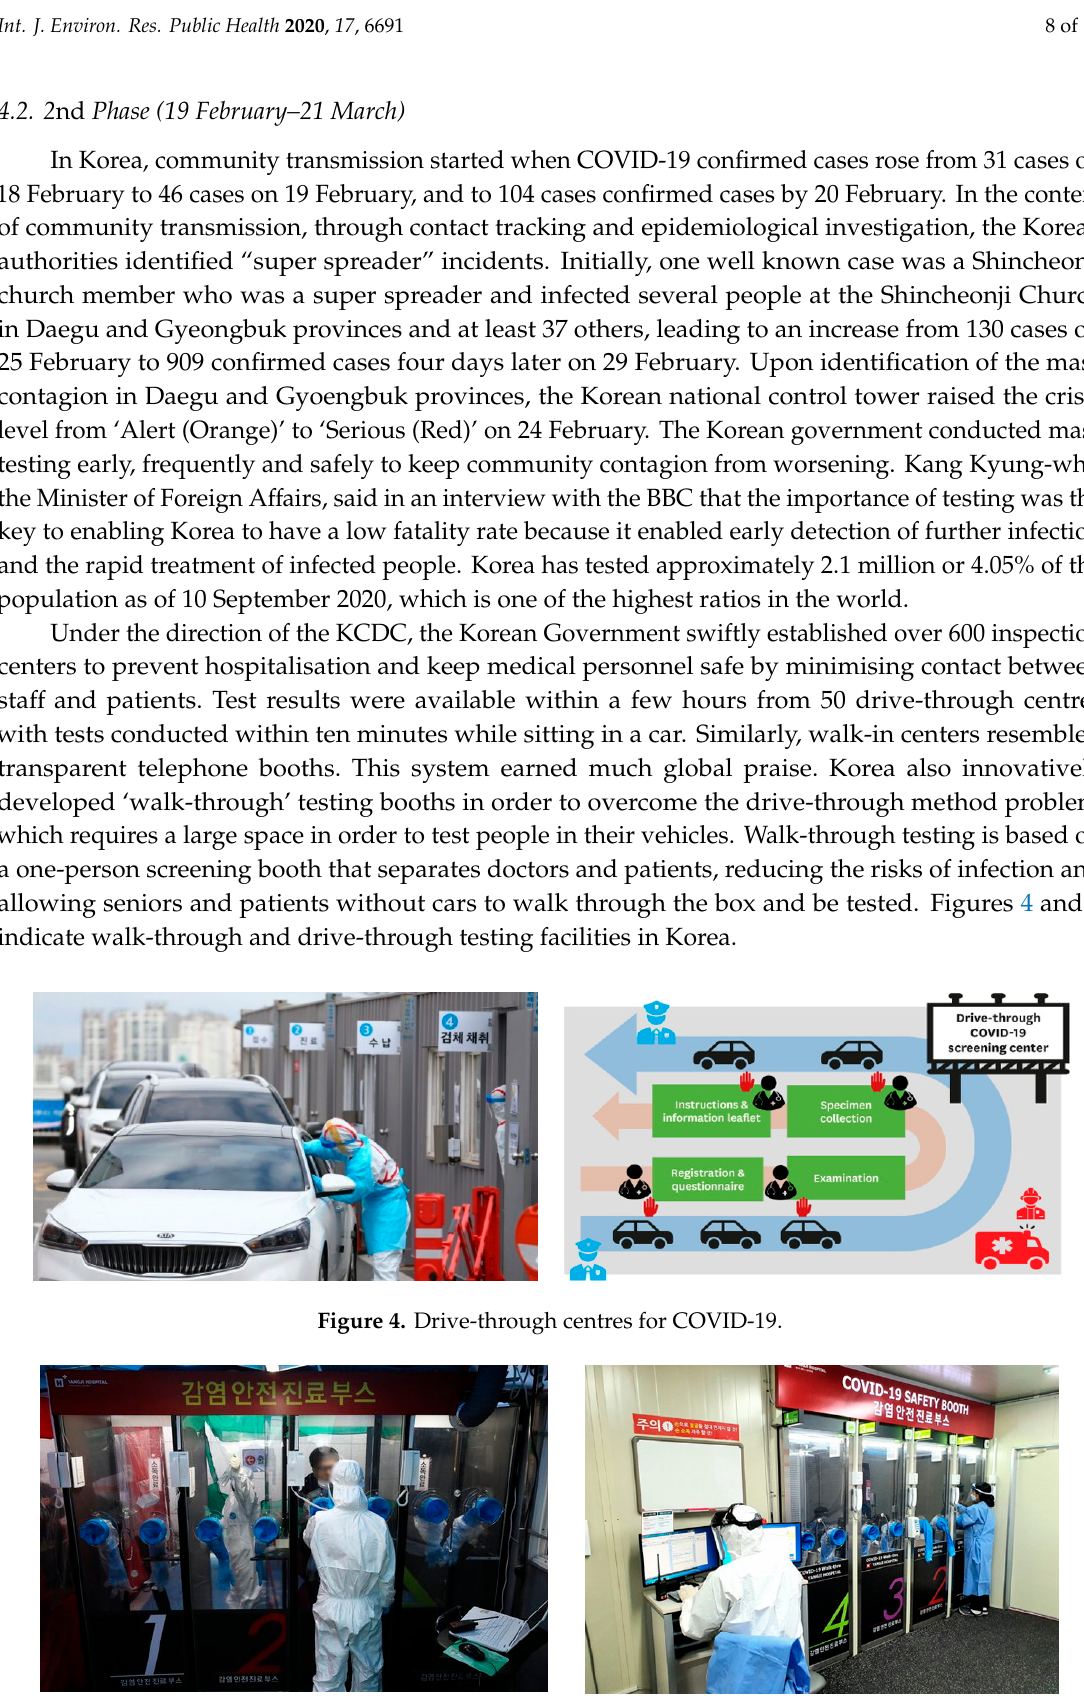
Figure 5. COVID-19 Safety Booth (Walk-through centres) for COVID-19.